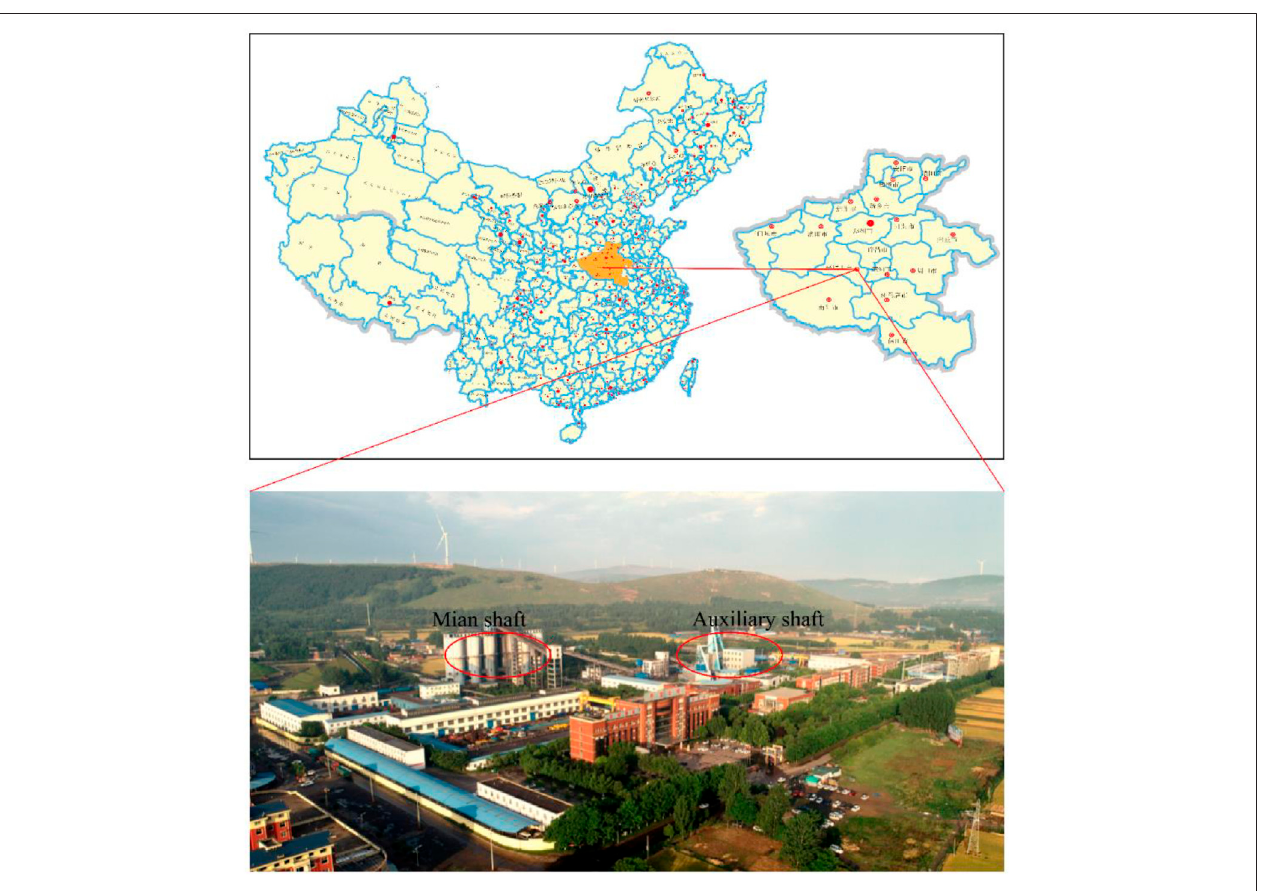
FIGURE 1 | Geographical location of the Shoushan